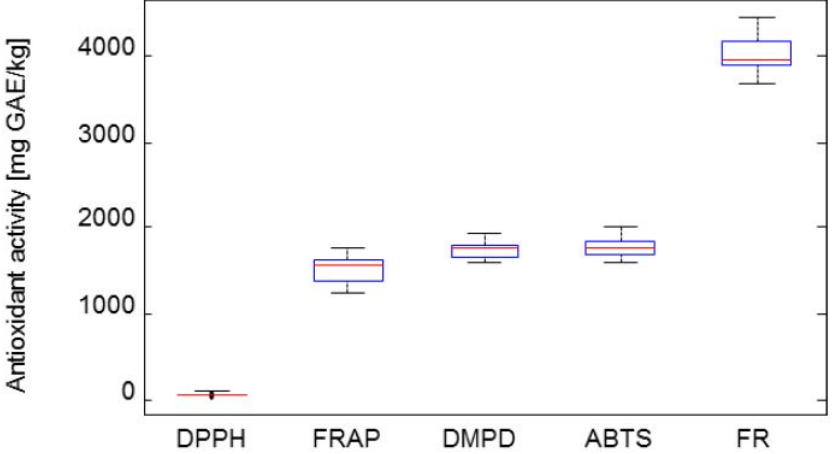
Figure 5. Box plot graphs of antioxidant activity. The results are given in equivalents of gallic